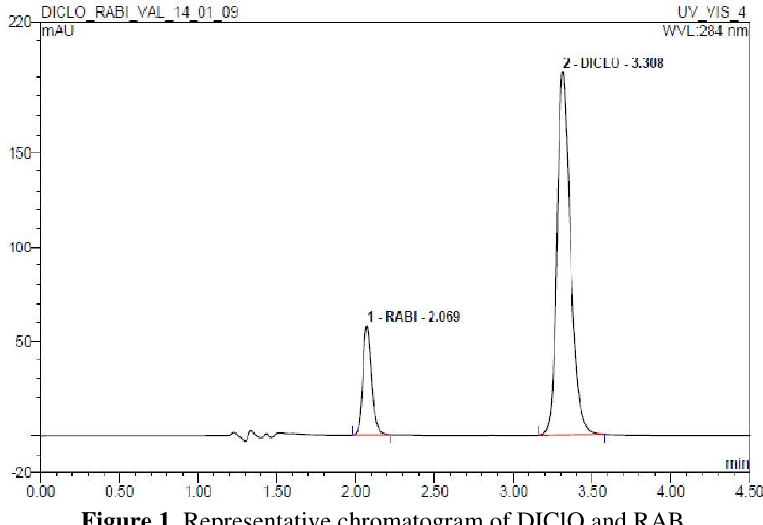
Figure 1. Representative chromatogram of DIClO and